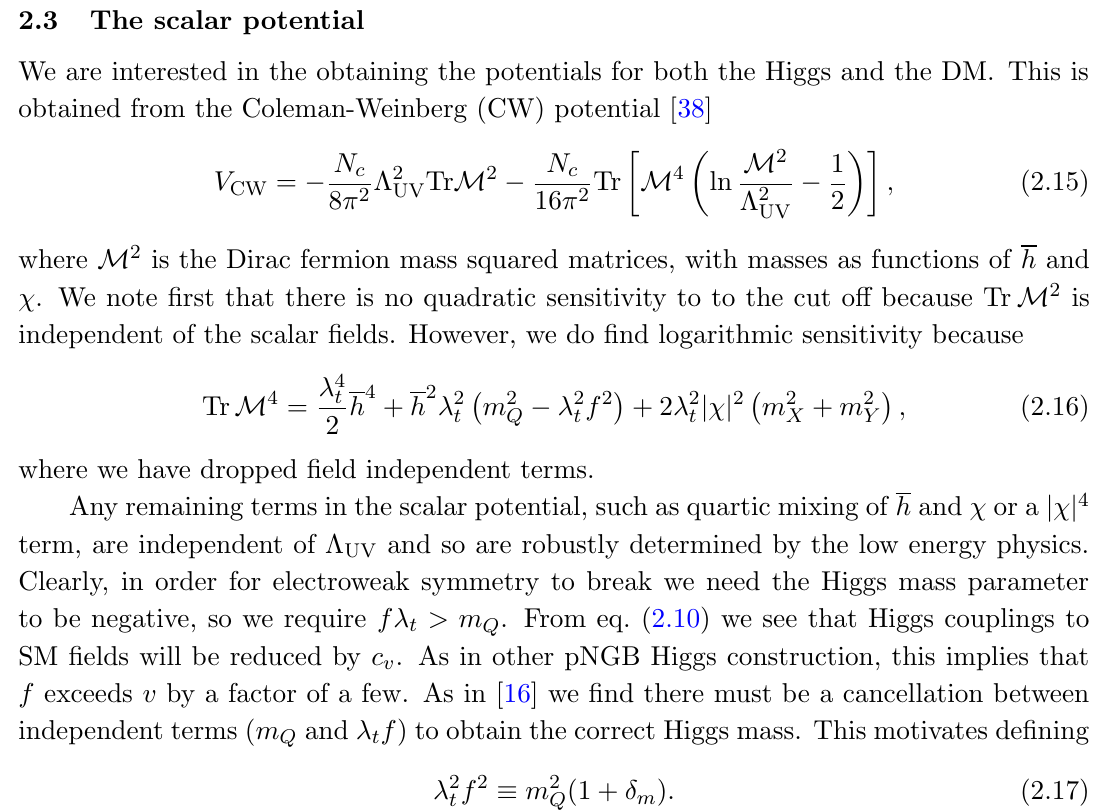
X Figure 1 . These Feynman diagrams show cancelation of quadratic divergences due to SU(3) c b top quark and SU(3) top quark for the SM-like Higgs H (upper row) and the complex scalar (cid:31) c (lower b